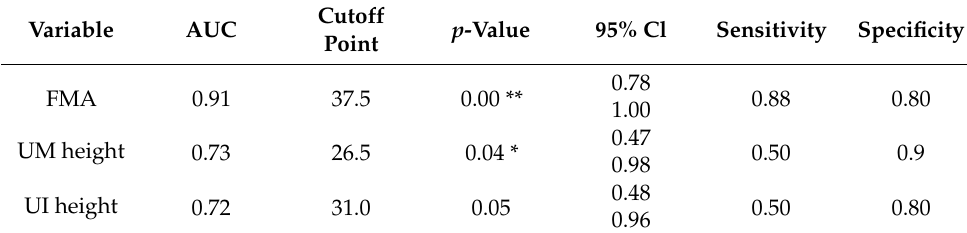
Table 3. Results of the ROC curve analysis for Group S and Group I.